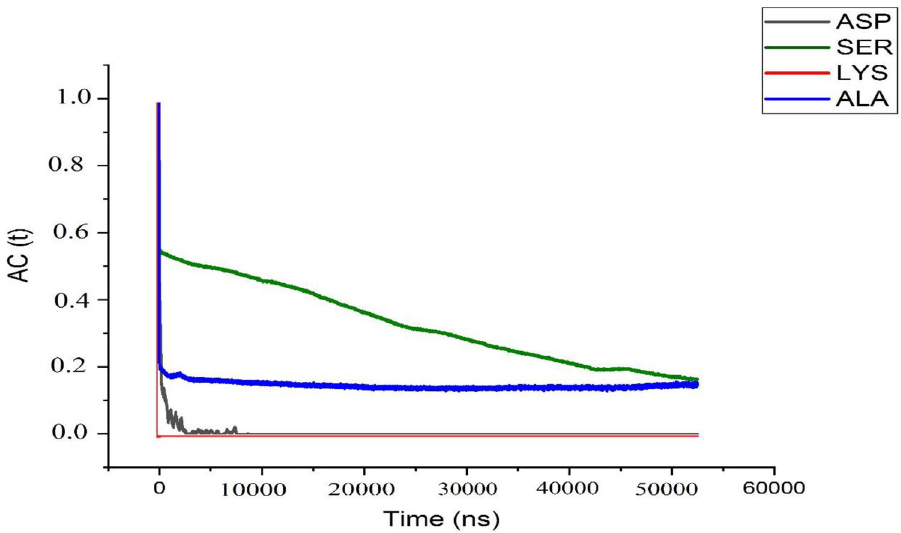
Figure 7. Hydrogen bond autocorrelation function between the amino acids and the carrier